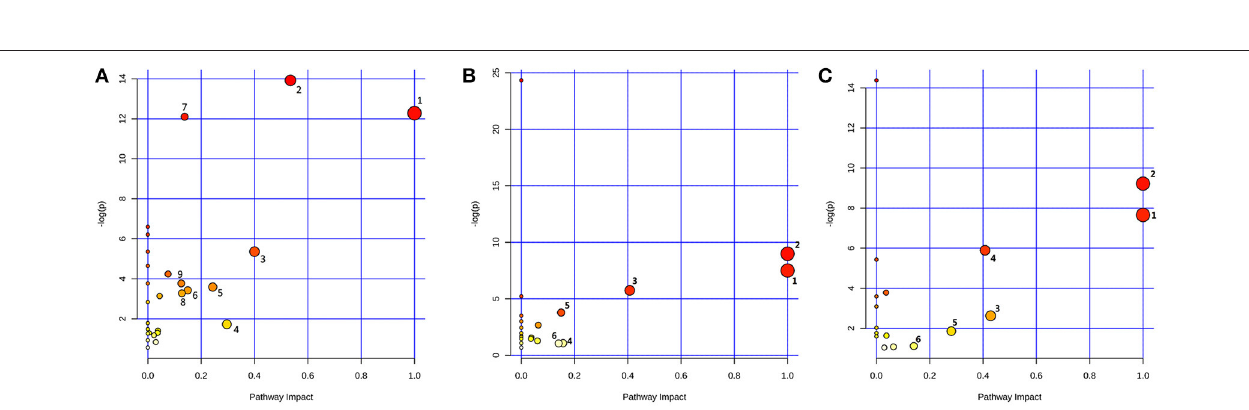
FIGURE 7 | Metabolic Pathway Analysis of plasma (A) , liver (B), and kidney (C) . The impact is the pathway impact value calculated from pathway topology analysis. Plasma: 1.Valine, leucine, and isoleucine biosynthesis; 2.Glycine, serine and threonine metabolism; 3.Methane metabolism; 4.Glyoxylate and dicarboxylate metabolism; 5.Pyruvate metabolism; 6.Alanine, aspartate and glutamate metabolism; 7.Aminoacyl-tRNA biosynthesis; 8.Glycolysis or Gluconeogenesis; 9.Citrate cycle (TCA cycle). Liver: 1.Phenylalanine, tyrosine and tryptophan biosynthesis; 2.Valine, leucine and isoleucine biosynthesis; 3.Phenylalanine metabolism; 4.Tryptophan metabolism; 5.Alanine, aspartate and glutamate metabolism; 6.Tyrosine metabolism. Kidney: 1.Phenylalanine, tyrosine and tryptophan biosynthesis; 2.Valine, leucine and isoleucine biosynthesis; 3.Taurine and hypotaurine metabolism; 4.Phenylalanine metabolism; 5.Glycerolipid metabolism; 6.Tyrosine metabolism.